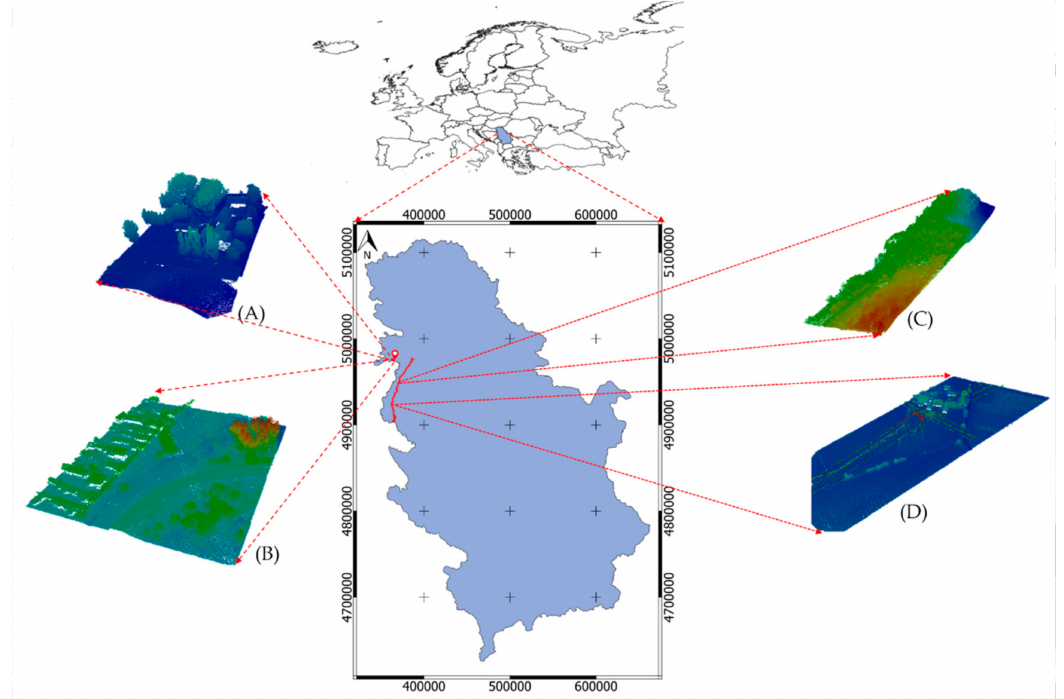
Figure 1. Study area location. Four study sites (A, B, C, D). The coordinate reference system is WGS84 / UTM34 34N EPSG